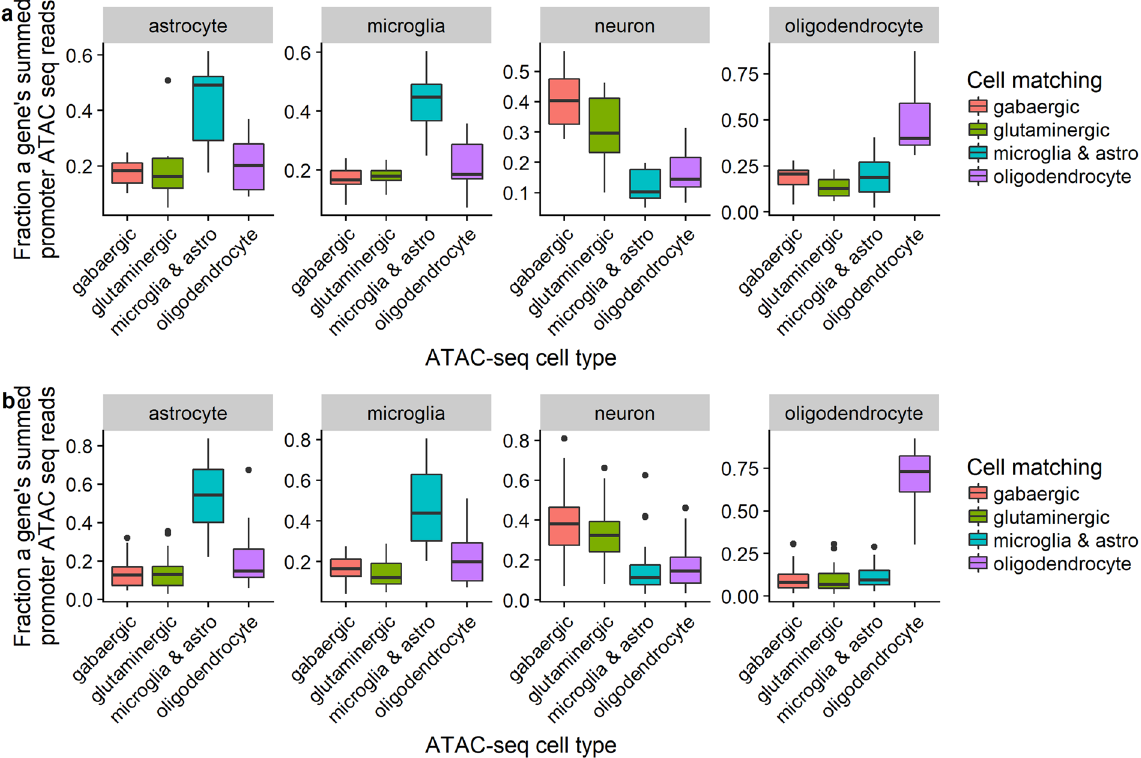
Figure 7. Relative chromatin accessibility in ( a ) novel and ( b ) known brain cell type marker genes by ATAC- seq. Relative chromatin accessibility, as measured by Assay for Transposase-Accessible Chromatin sequencing (ATAC-seq), at the promoters of novel candidate cell marker genes in four different ATAC-seq cell populations from the adult human brain. “Marker” genes were defined as top cell type-specific genes for a particular cell type. In each panel, the boxplots show the distribution of the fraction of ATAC-seq reads regarding novel markers of a particular cell type. Astro, astrocytes.